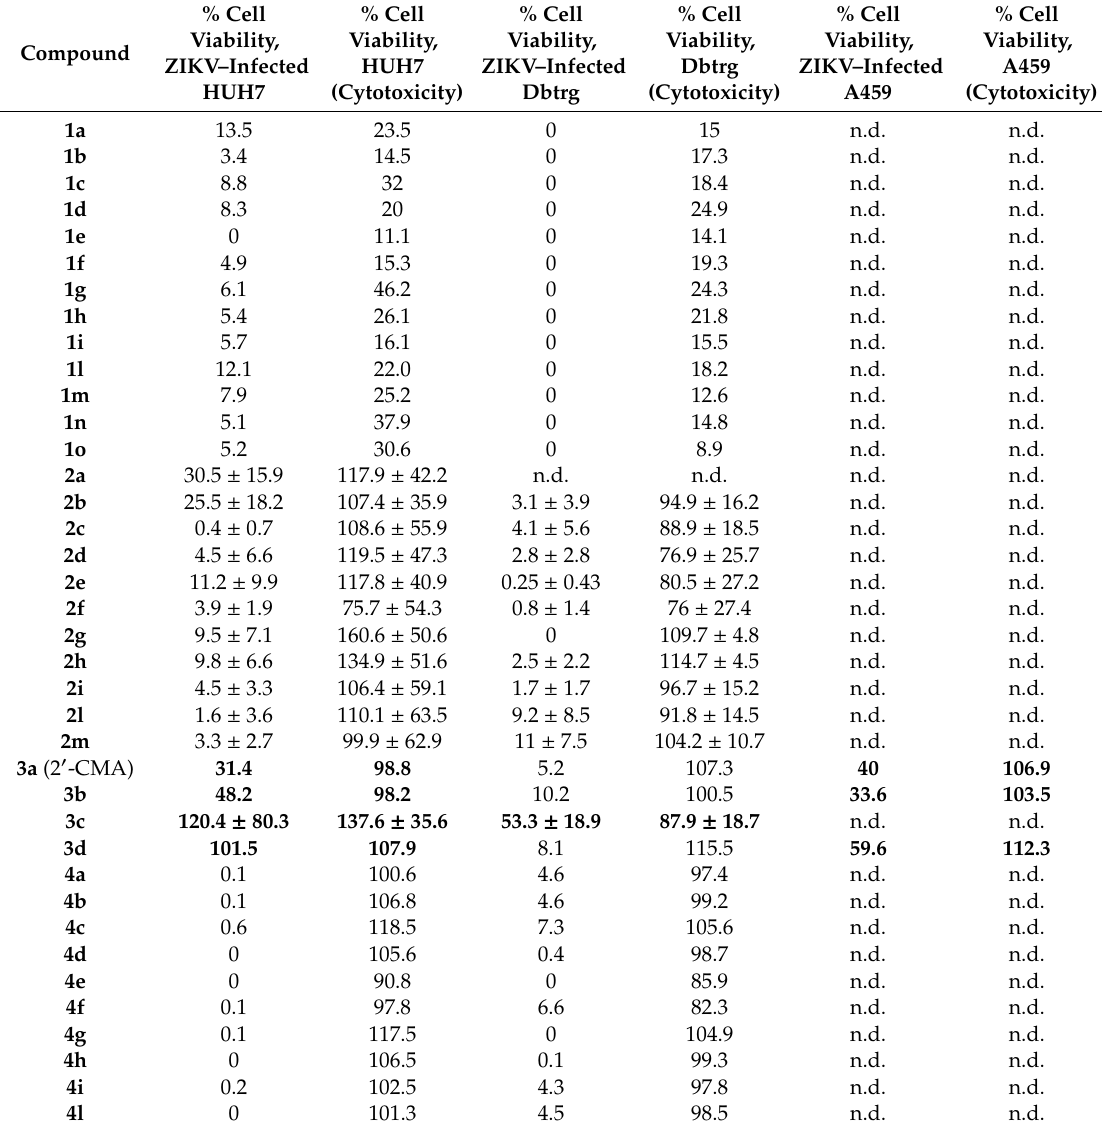
Table 2. Reduction in ZIKV-induced cytopathic e ff ect (CPE) and cytotoxicity data for the selected compounds at a fixed 10 µ M concentration in multiple cell lines 1 . % Compound